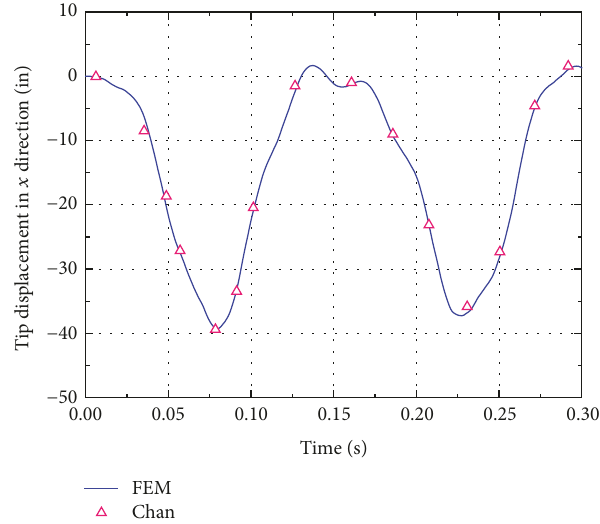
Figure 11: X-direction displacement of beam free end.